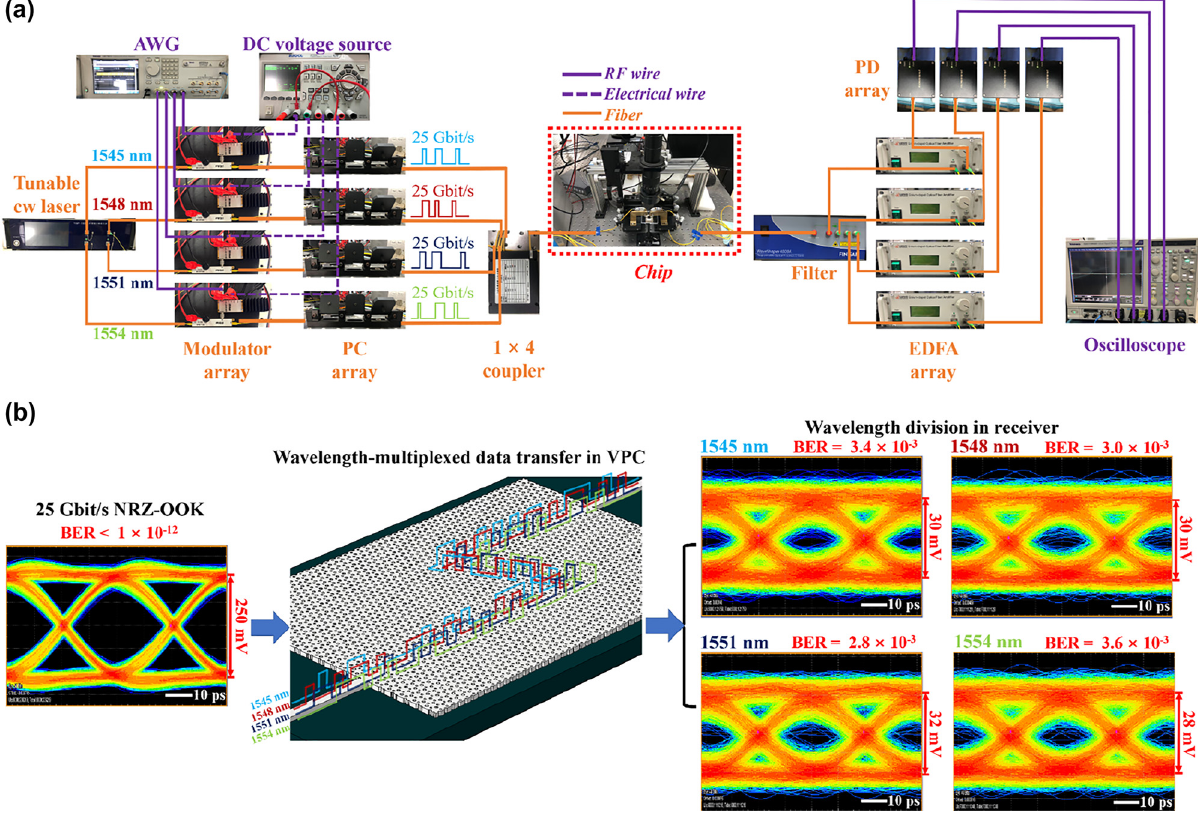
Figure 6: On-chip optical communication in the telecom band based on WDM. (a) The experimental setup for the WDM-based on-chip optical communication test. (b) Eye diagrams and BERs of the 25 Gbit/s arbitrary NRZ-OOK electrical signal (left) and the received data with different wavelengths (right). Schematic diagram of the wavelength-multiplexed data transfer in the Z-type domain wall formed by the SZ-interface